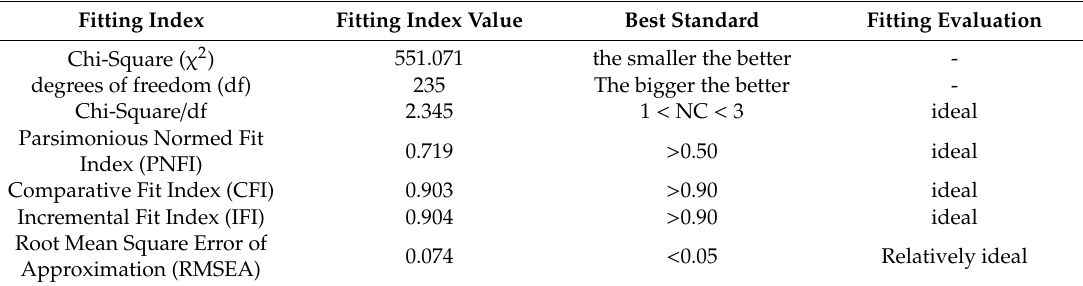
Table 4. Fitting index of the modified structural equation